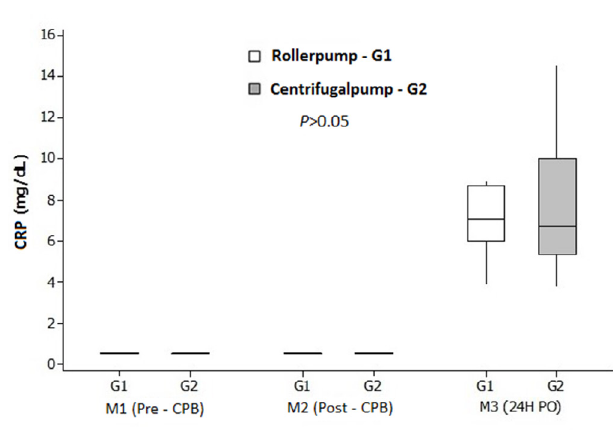
Fig. 2 – Median (range) CRP levels, stratified by group and time point.